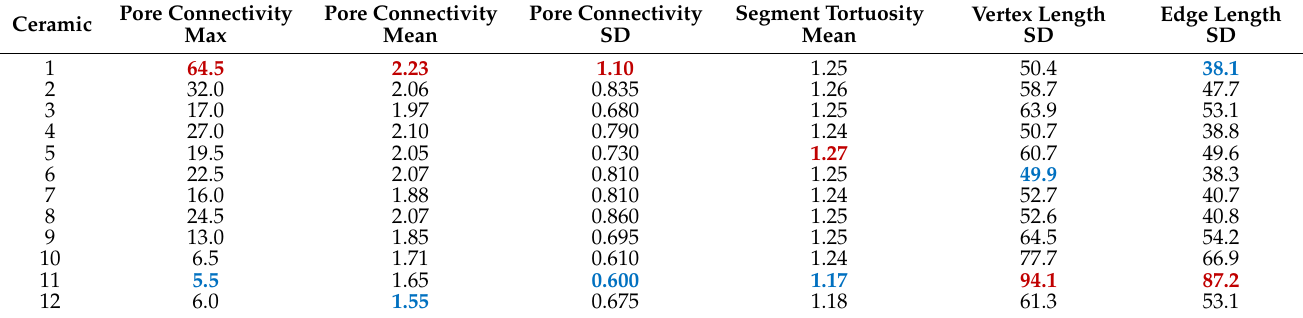
Table 6. Significant pore variables ( p < 0.05); dense